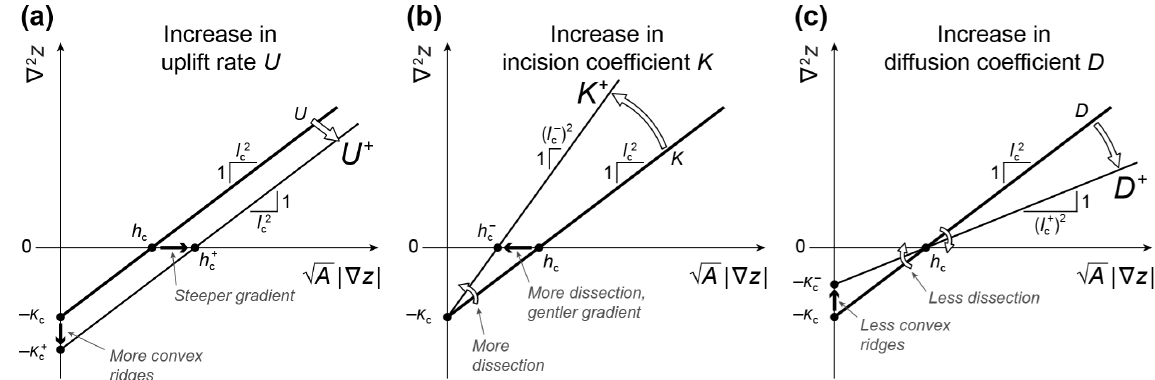
Figure 3. Graphical illustration, using curvature–steepness index lines, of how parameters influence landscape properties. The three plots show how curvature–steepness index lines respond to increases in the uplift rate U , incision coefficient K , and diffusion coefficient D . (a) An increase in U parallel-shifts the line to the right and downward. This makes the vertical-axis intercept smaller (more negative) and the horizontal-axis intercept bigger, showing that ridges become more convex and that gradients become steeper (i.e., relief becomes higher). The line’s slope remains 1 /l 2 c , indicating that the scale of dissection does not change. (b) An increase in K rotates the line counterclockwise around the vertical-axis intercept. This makes the horizontal-axis intercept smaller and the line’s slope bigger, showing that gradients become gentler (i.e., relief becomes lower) and that the landscape becomes more dissected (i.e., the scales of dissection become smaller). (c) An increase in D rotates the line clockwise around the horizontal-axis intercept. This moves the vertical-axis intercept closer to zero and decreases the line’s slope, showing that ridges become less convex and that the landscape becomes less dissected (i.e., the scales of dissection become